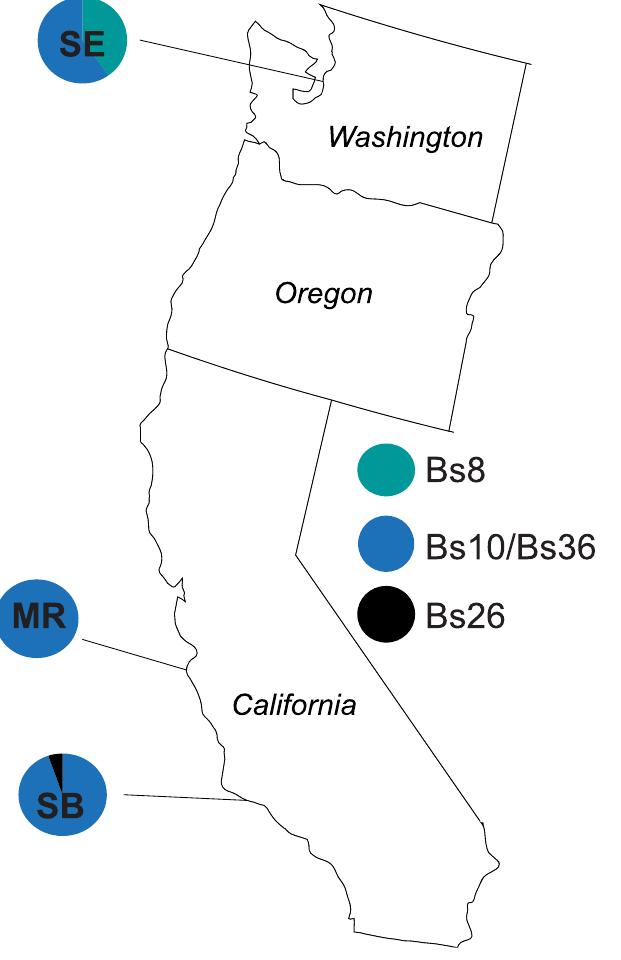
Fig 3. Clade A haplotype frequencies in the eastern Pacific populations sampled by the authors of this study. The population abbreviationsare as follows: MR = Monterey,CA, USA; SB = Santa Barbara, CA, USA; SE = Seattle, WA, USA. Small cross-marks represent mutational